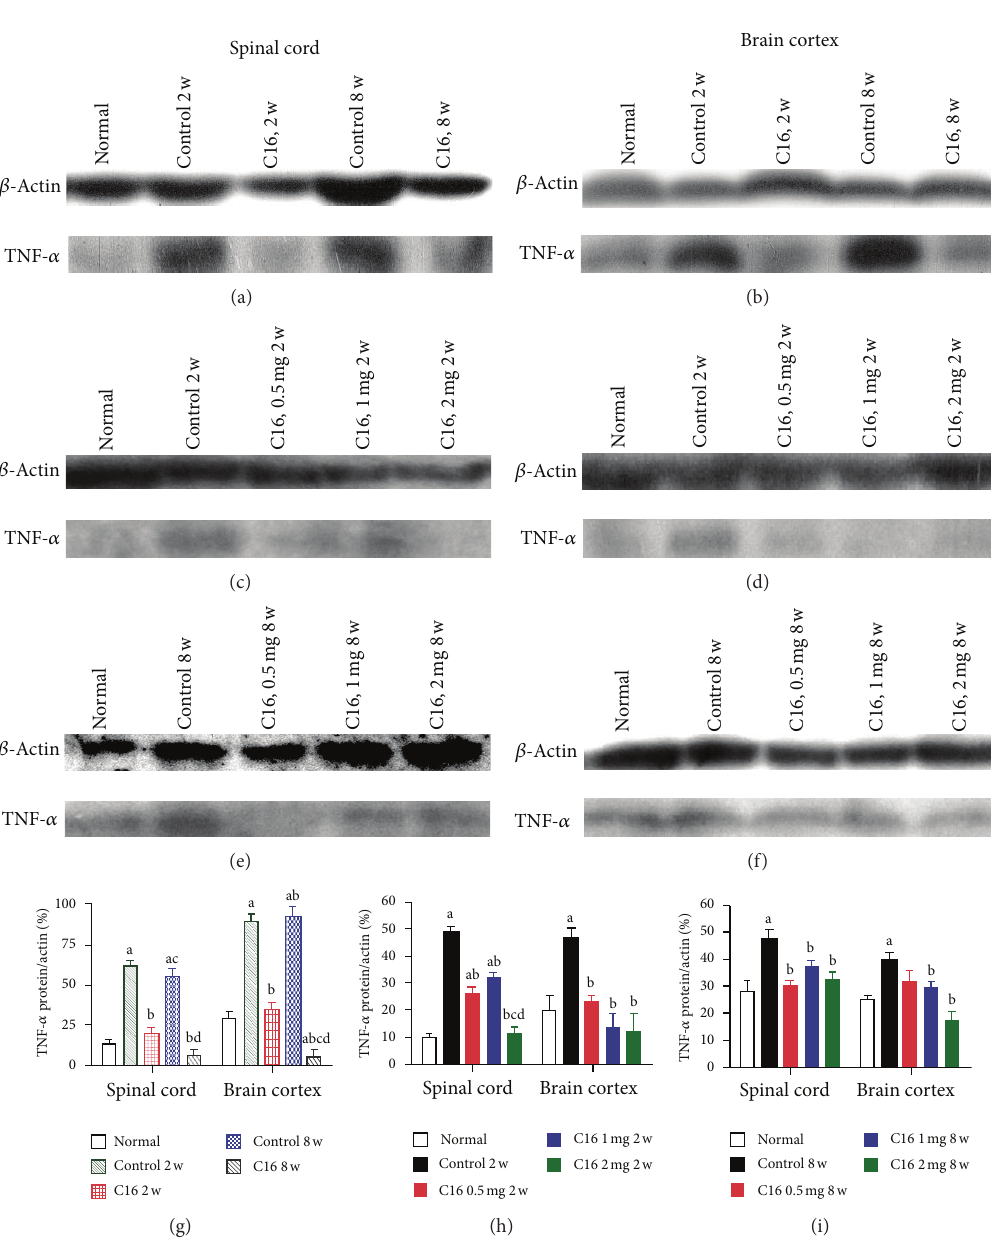
Figure 14: ((a), (b)) The levels of TNF- 𝛼 expression were declined remarkably by late C16 application both in spinal cord (a) and cerebral cortex (b) compared with the vehicle control, evaluated by Western blotting analysis. ((c), (d)) The levels of TNF- 𝛼 expression were evidently decreased both in spinal cord (c) and cerebral cortex (d) by medium to high-dose C16 treatment at week 2 post-immunization. ((e), (f)) The levels of TNF- 𝛼 expression were evidently decreased both in spinal cord (e) and cerebral cortex (f) by medium to high-dose C16 treatment at week 8 post-immunization. (g) The levels of TNF- 𝛼 expression were suppressed by C16 late treatment to a certain extent. a 𝑃 < 0.05 versus normal rats; b 𝑃 < 0.05 versus vehicle control rats; c 𝑃 < 0.05 versus C16 treated EAE rats at week 2 postimmunization group; d 𝑃 < 0.05 versus vehicle control rats at week 8 after immunization. (h) The levels of TNF- 𝛼 expression were reduced by medium to high-dose C16 treatment at week 2 after immunization. (i) The levels of TNF- 𝛼 expression were reduced by medium to high-dose C16 treatment at week 8 after immunization. a 𝑃 < 0.05 versus normal rats; b 𝑃 < 0.05 versus vehicle control rats; c 𝑃 < 0.05 versus 0.5 mg/per day C16 treated EAE rats; d 𝑃 < 0.05 versus 1mg/per day C16 treated EAE